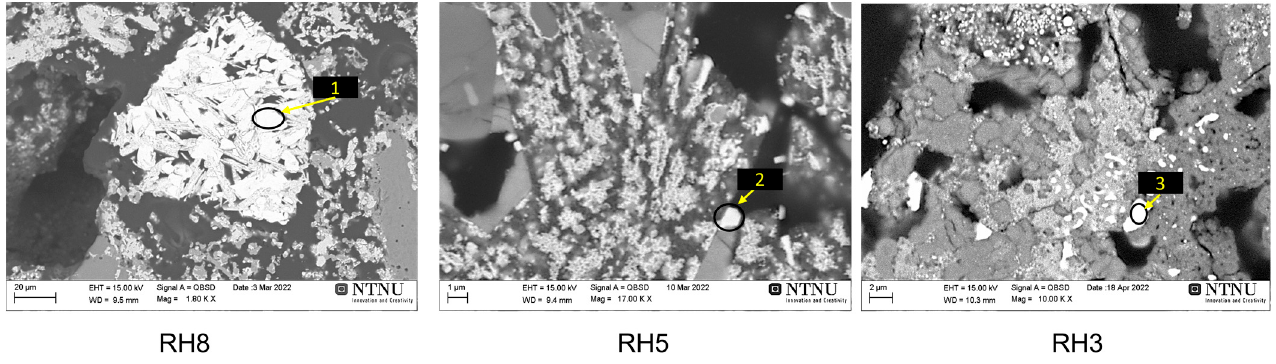
Figure 15. Transition of iron complexes to metallic iron with increasing reduction temperature and elemental of analysis of RH8, RH5 and RH3 are pointed as 1, 2 and 3 respectively. Table 2. Comparison of atomic fraction in EDS elemental analysis of RH3, RH5 and RH8. Sample/Elements (at.